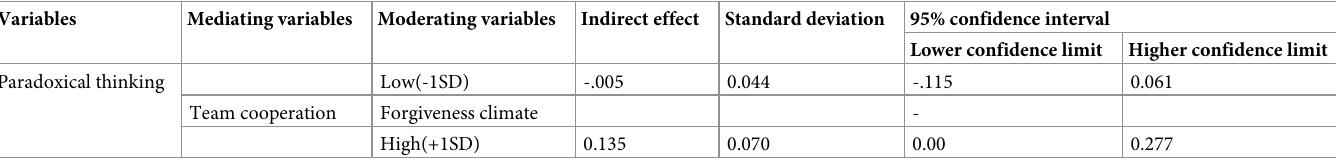
Table 5. Bootstrap test of moderated mediating